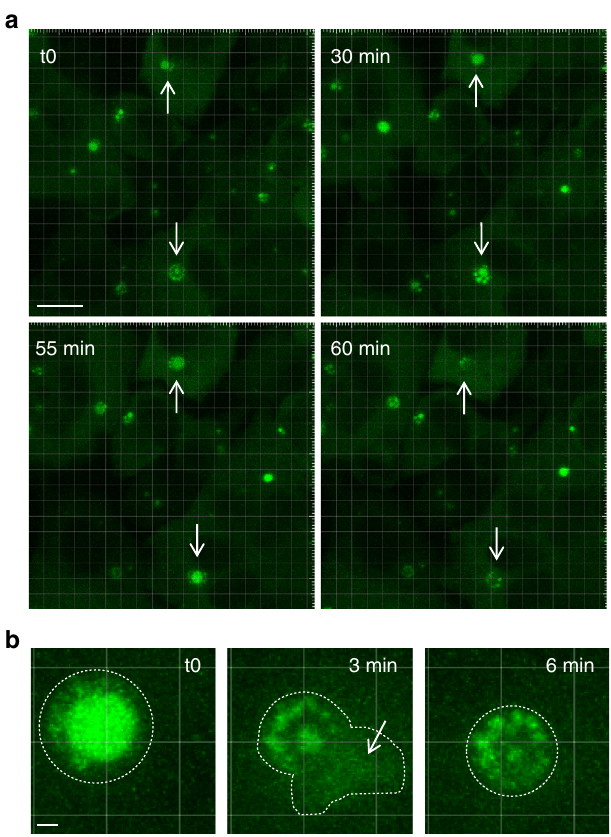
Fig 8 IBAGs are dynamic structures. Time-lapse microscopy of IBAGs in HEp-2 cells infected with RSV-M2-1mGFP. At 24 h p.i., cells were imaged in a chamber heated at 37 °C, with a Leica SP8 confocal microscope. The M2- 1mGFP protein was visualized by green fl uorescence. Representative images from fi ve independent experiments are shown. a Representative images of IBAG dynamics. White arrows indicate IBs undergoing IBAG growth, followed by IBAG collapse. Scale bar 10 µ m. b Time-lapse imaging of an IB showing IBAG disassembly (regions of interest). The dotted line indicates the IB boundary as determined on the fi rst and last image. The central image suggests the release of the IBAG content into the cytoplasm indicated by a white arrow . Scale bar 1 µ